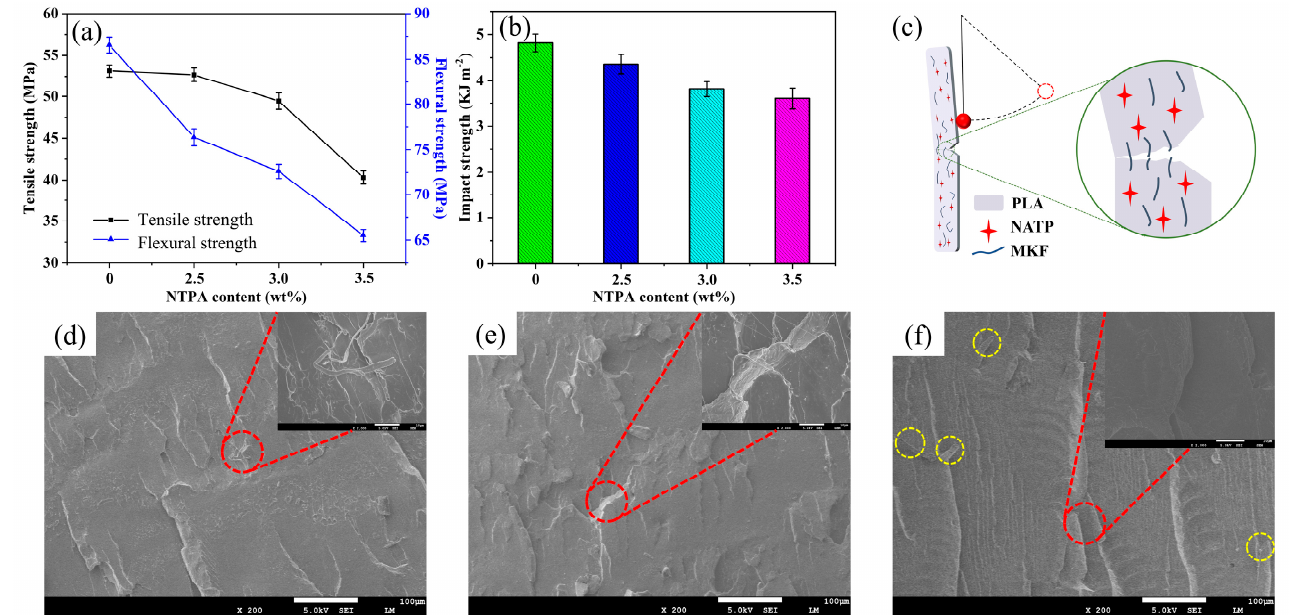
Figure 6. Mechanical properties of PLA/MKF/NTPA biocomposites. ( a ) Tensile strength and flexural strength, ( b ) notched Izod impact strength. ( c ) Energy absorption effect of MKF in impact tests. SEM images (200× and 2000×) of the fracture surfaces of ( d ) PLA0, ( e ) PLA2.5, and ( f ) PLA3.0.